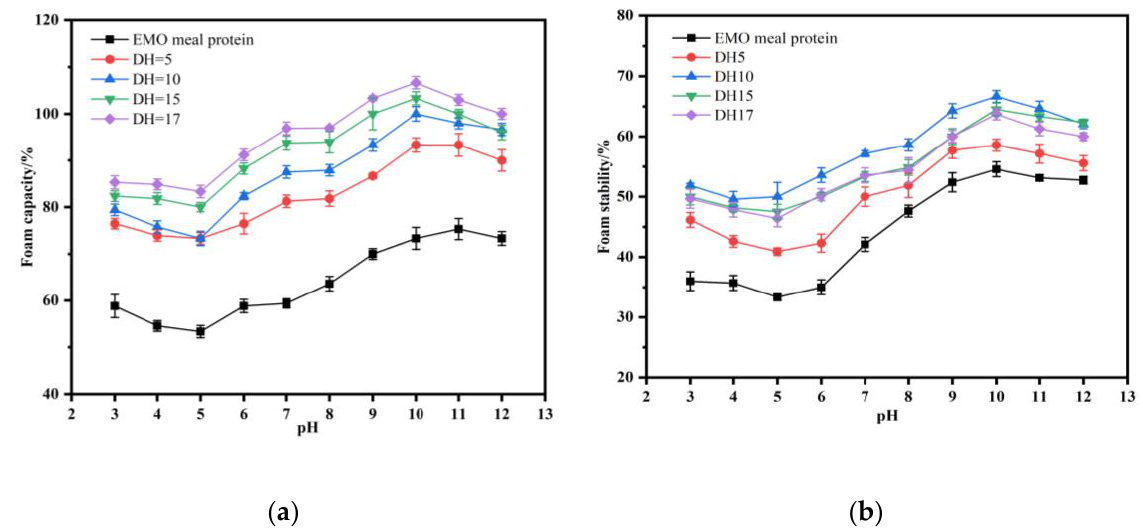
Figure 8. Effect of pH on foam capacity ( a ) and foam stability ( b ) of the EMO meal protein and hydrolysates with different DH.